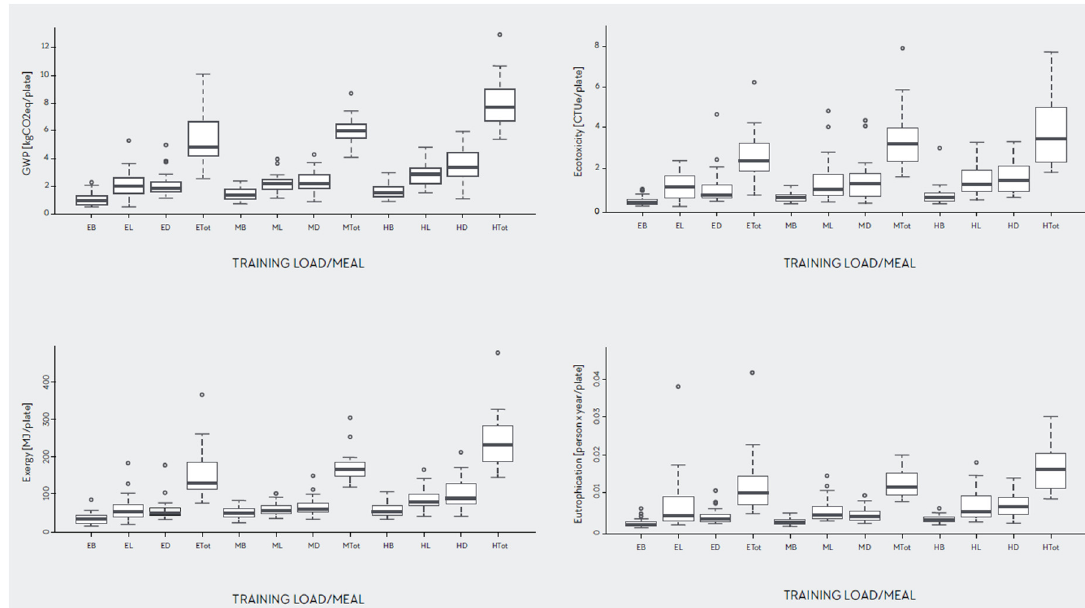
Figure 7. Boxplots by training load and meals for all four environmental categories. EB: Easy breakfast; EL: easy lunch; ED: easy dinner; Etot: easy daily totals; MB: moderate breakfast; ML: moderate lunch; MD: moderate dinner; Mtot: moderate daily totals; HB: hard breakfast; HL: hard lunch; HD: hard dinner; Htot: hard daily totals. Table 3. Standard deviation of the environmental impacts of the 12 dietitians (easy, moderate and hard plates) for daily totals (sum of breakfast, lunch and dinner).